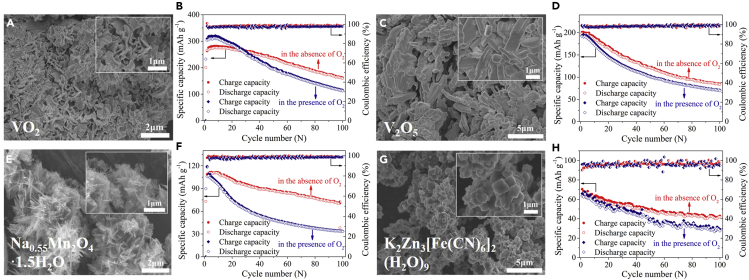
The Impact of the Dissolved O2 in Aqueous ZIBs with Cathodes of VO2, V2O5, Na0.55Mn2O4·1.5H2O, and K2Zn3[Fe(CN)6]2·(H2O)9 Using the 2 M ZnSO4Electrolytes in the Presence of O2 and in Absence of O2(A) SEM characterization of VO2.(B) Cycling stability of Zn-VO2 batteries at 0.1 A g−1 with a voltage window of 0.2–1.6 V.(C) SEM characterization of V2O5.(D) Cycling stability of Zn-V2O5 batteries at 0.1 A g−1 with a voltage window of 0.2–1.6 V.(E) SEM characterization of Na0.55Mn2O4·1.5H2O.(F) Cycling stability of Zn-Na0.55Mn2O4·1.5H2O batteries at 0.1 A g−1 with a voltage window of 1–1.8 V.(G) SEM characterization of K2Zn3[Fe(CN)6]2·(H2O)9.(H) Cycling stability of Zn-K2Zn3[Fe(CN)6]2·(H2O)9 batteries at 0.1 A g−1 with a voltage window of 0.8–1.9 V.